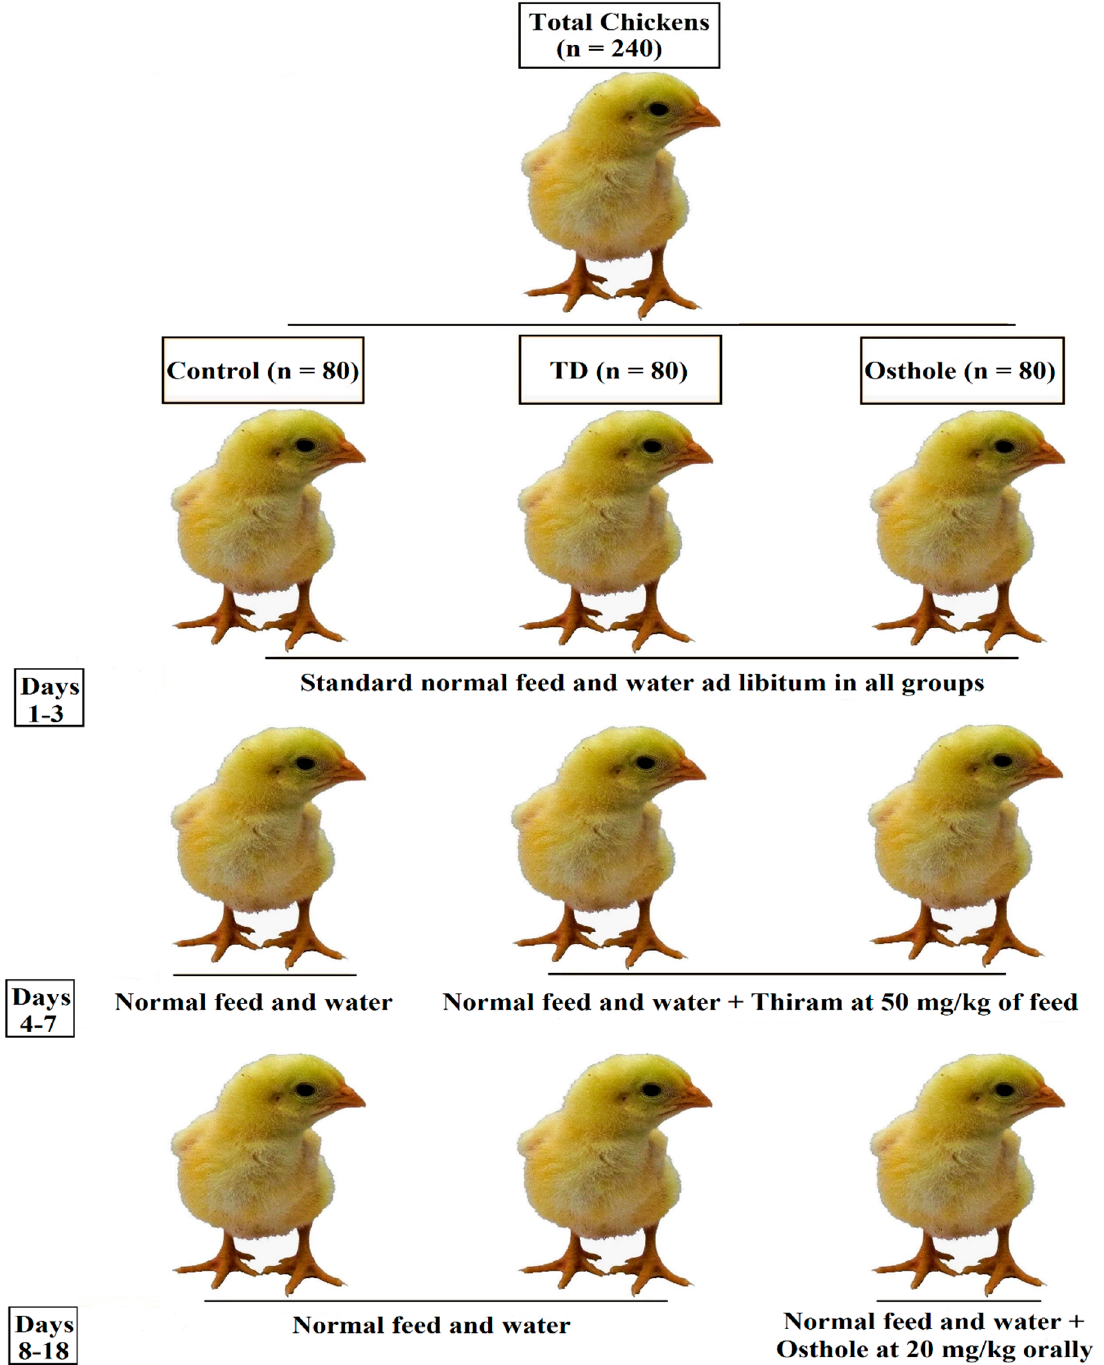
Figure 2. Experiment design.